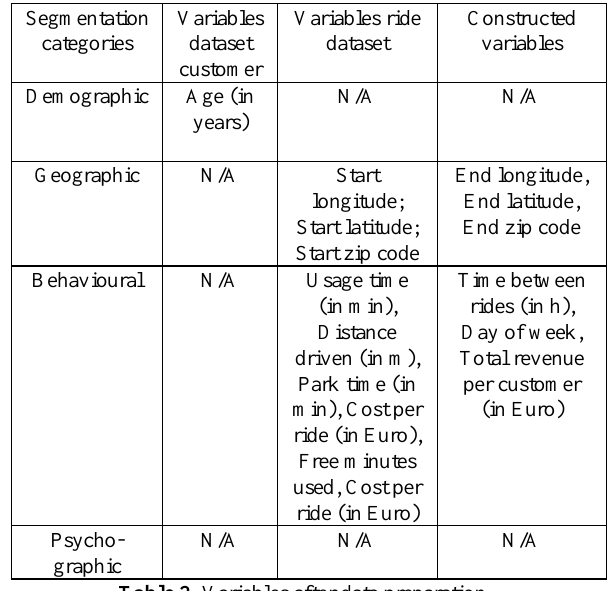
Table 2. Variables after data